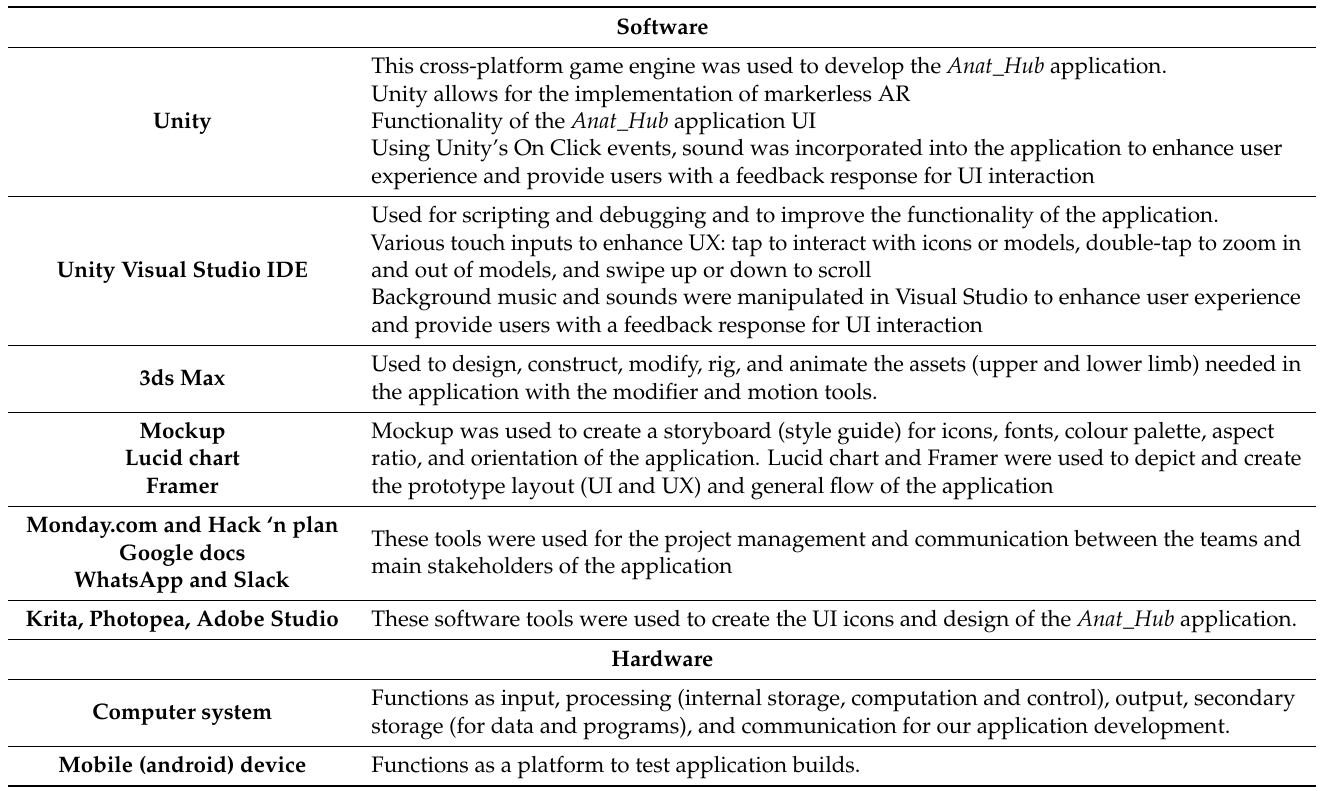
Table 2. Functions of the various software and hardware used for the Anat_Hub application